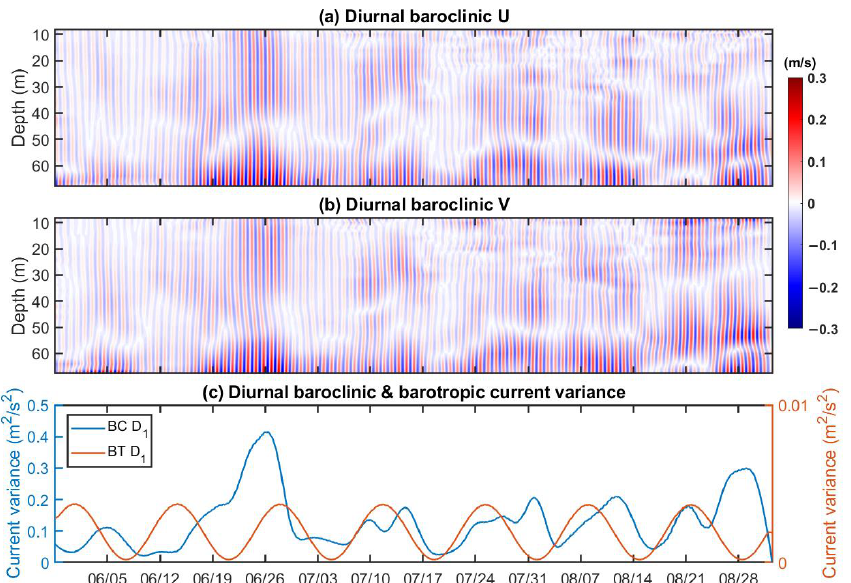
Figure 4. Same as in Figure 3 but for the diurnal baroclinic current and K 1 + O 1 barotropic tides. The semidiurnal current field was divided into two vertical sections: subsurface and lower middle. A zero-crossing point fluctuated over time between 20 and 36 m (Figure 3a,b). Near-bottom intensification featured prominently in the diurnal field, with